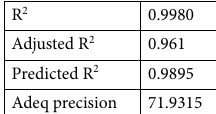
Table 3. Quality of fitted to experimental data.